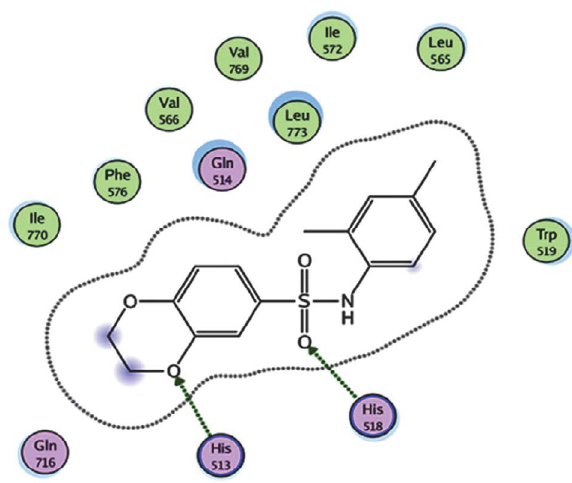
Figure 4: 2D interaction of N -(2,4-dimethylphenyl)-2,3-dihyd- robenzo[1,4]dioxine-6-sulfonamide ( 3b ) against lipoxygenase.